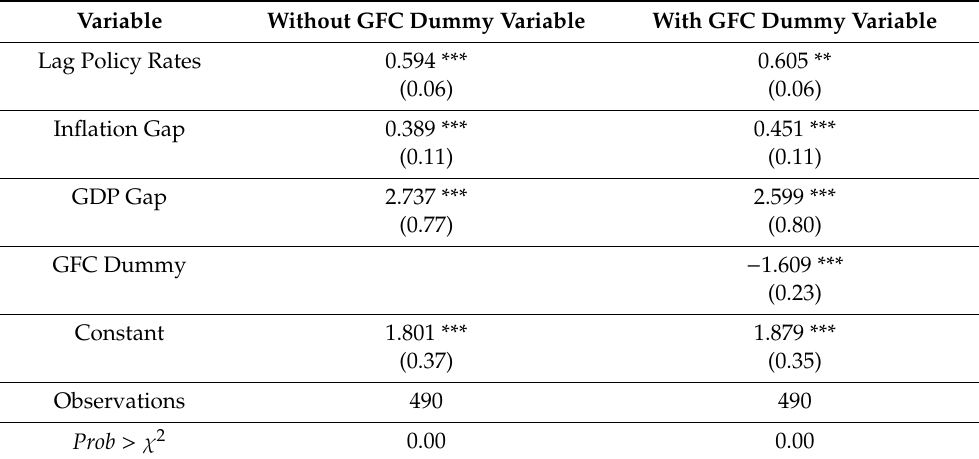
Table 2. The Baseline Taylor Rule (Model